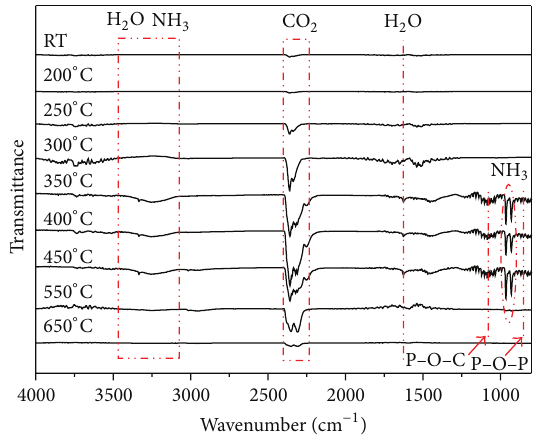
Figure 6: FTIR spectra of pyrolysis gases of the MPP/PEPA mixture at various temperatures. Note: the mass ratio of MPP to PEPA was